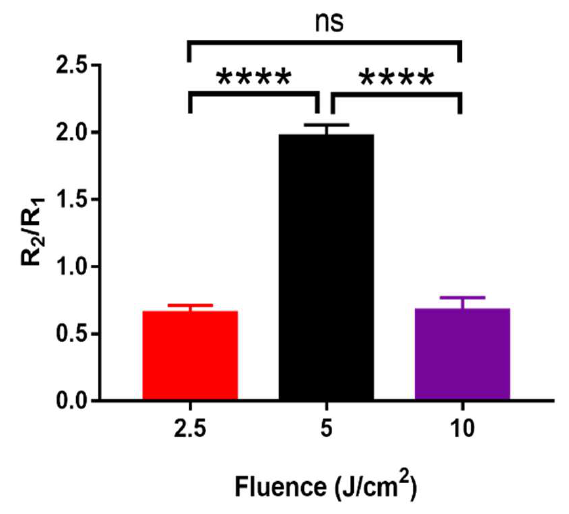
Figure 8. Bar charts representing the effects of PBM on intracellular ROS acquired in the hADSCs after 30 min PBM. These cells were spontaneously picked and photographed by an EMCCD camera following PBM at fluences of 2.5 J/cm 2 (Red), 5 J/cm 2 (Black), and 10 J/cm 2 (Purple). The values are the mean intensity ratio (mean ± SEM, n = 6). Statistical analysis (one-way ANOVA) showed significant changes in this study (**** p ≤ 0.0001; ns: p > 0.05).